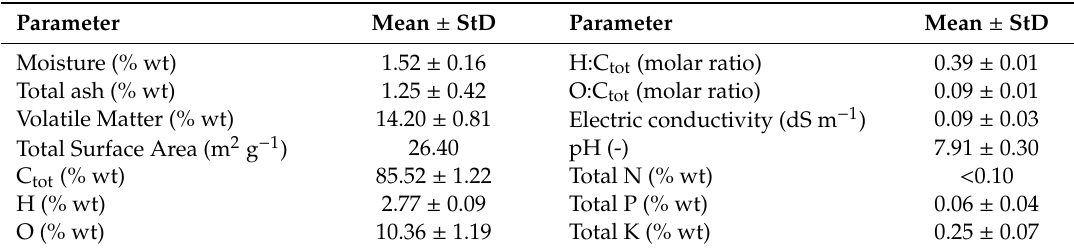
Table 3. Characterisation of biochar